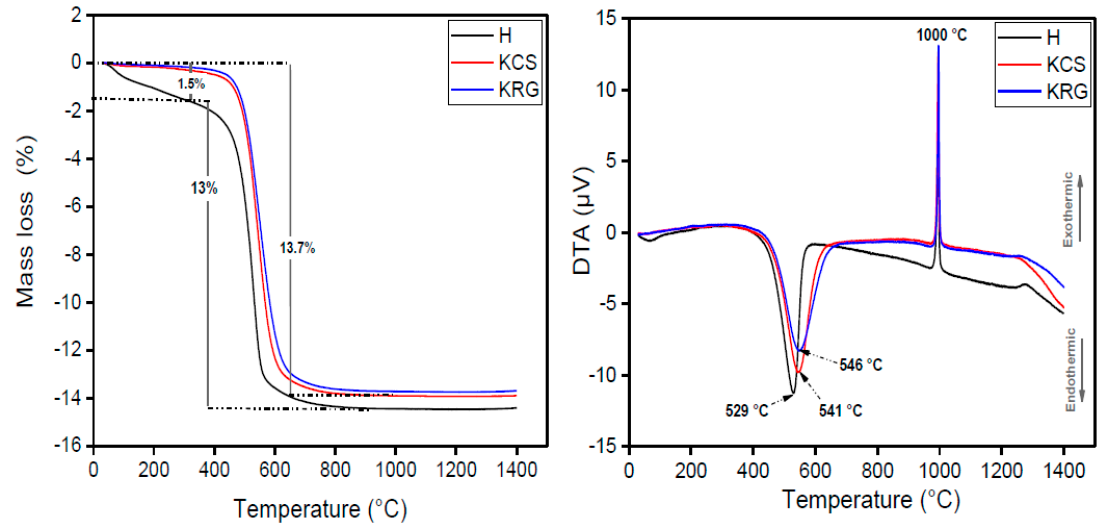
Figure 3. DTA/TGA for raw materials. Figure 3. DTA / TGA for raw